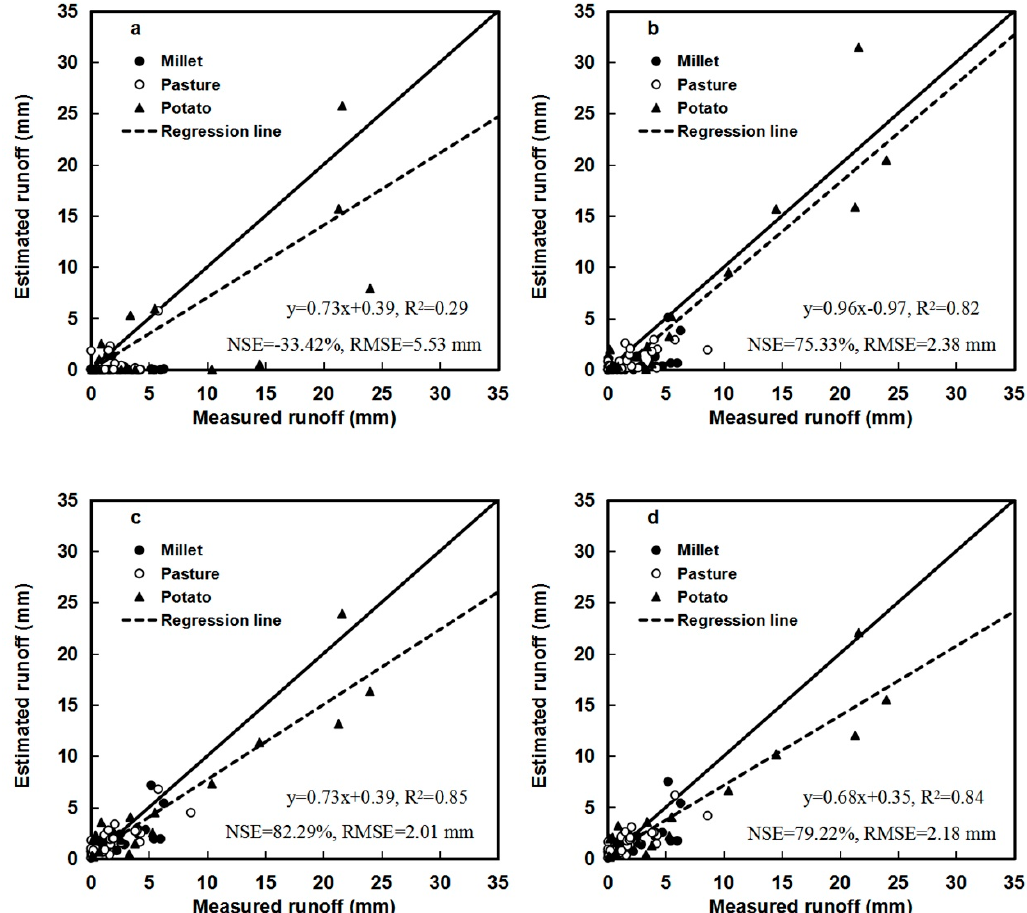
Figure 6. Measured versus estimated runoff depths for ( a ) original SCS-CN method, ( b ) Method 1, ( c ) Method 2, and ( d ) Method 3 for the three experimental plots located in the CBG watershed.